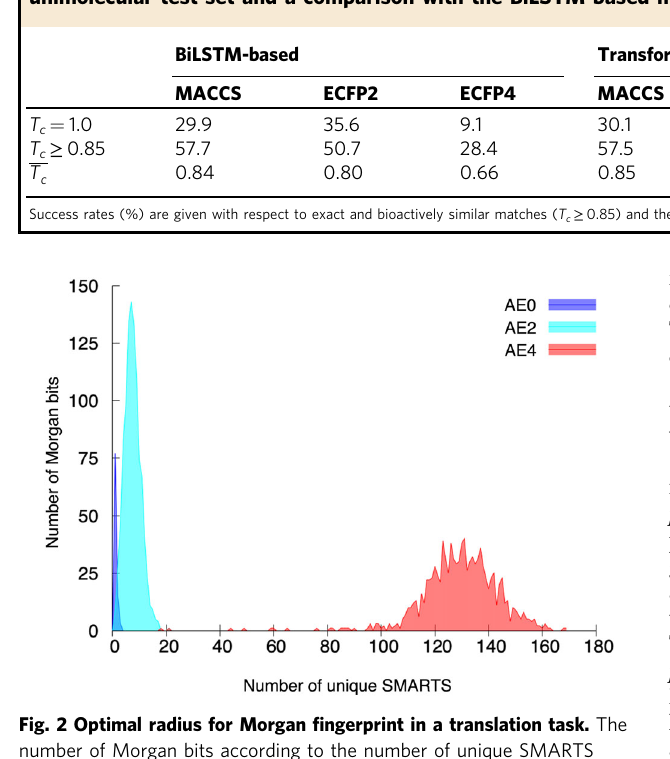
Table 1 Performance summary of various Transformer-based models trained with different fragmentation schemes in unimolecular test set and a comparison with the BiLSTM-based models.